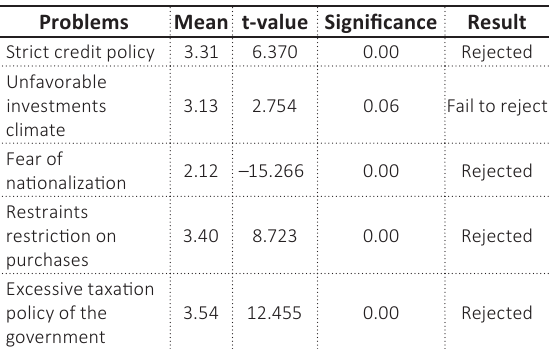
Table 12. Government and administrative